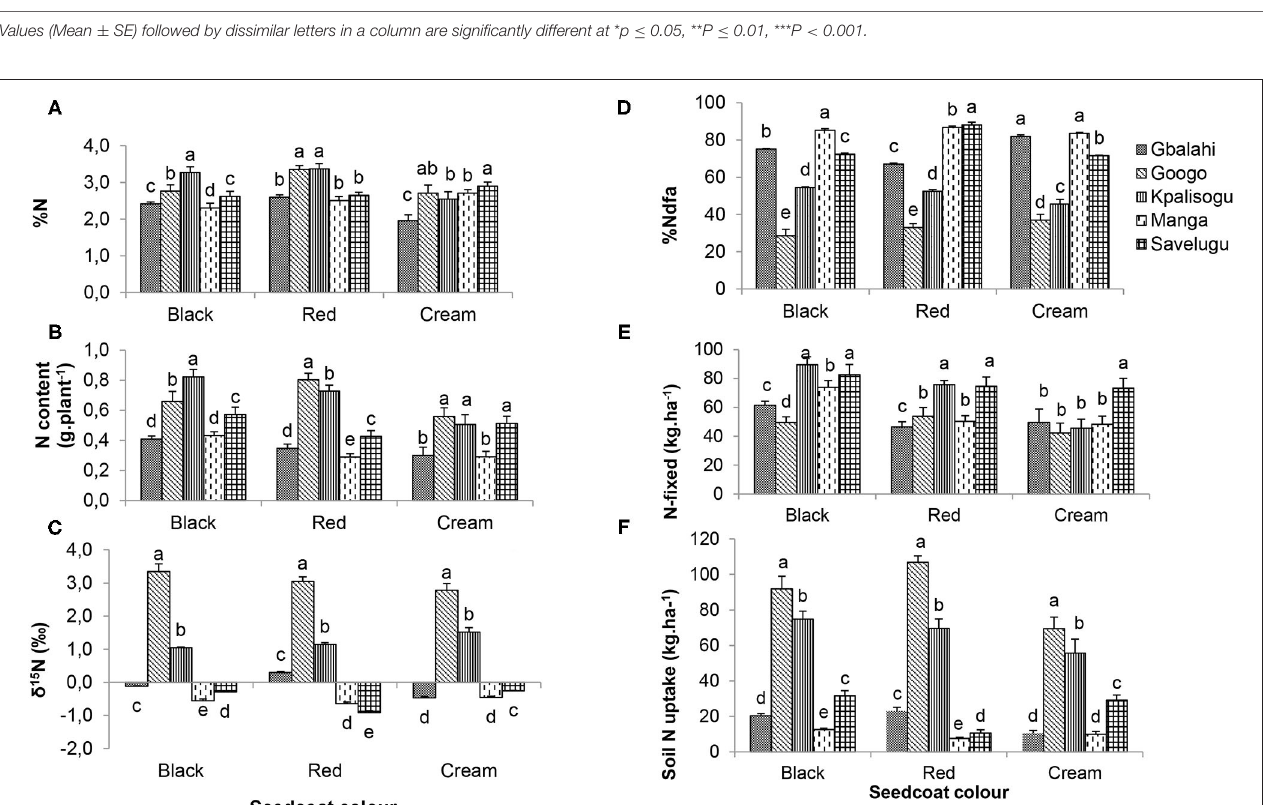
landrace recorded greater amounts of N-fixed at Kpalisogu and Savelugu, followed by Manga, and lowest at Googo and Gbalahi, which recorded much higher endogenous soil N concentrations that probably inhibited N 2 fixation (Mbah and Dakora, 2018).